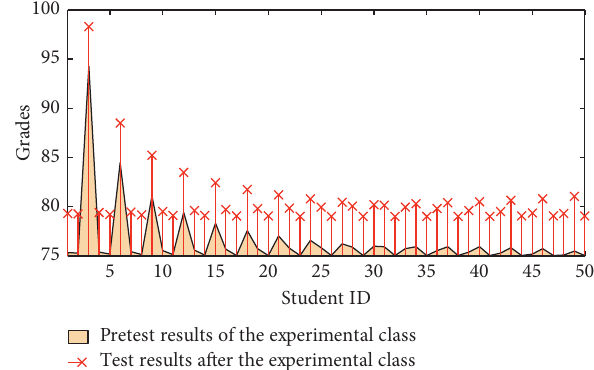
Figure 4: Test of the difference of test scores before and after the experimental